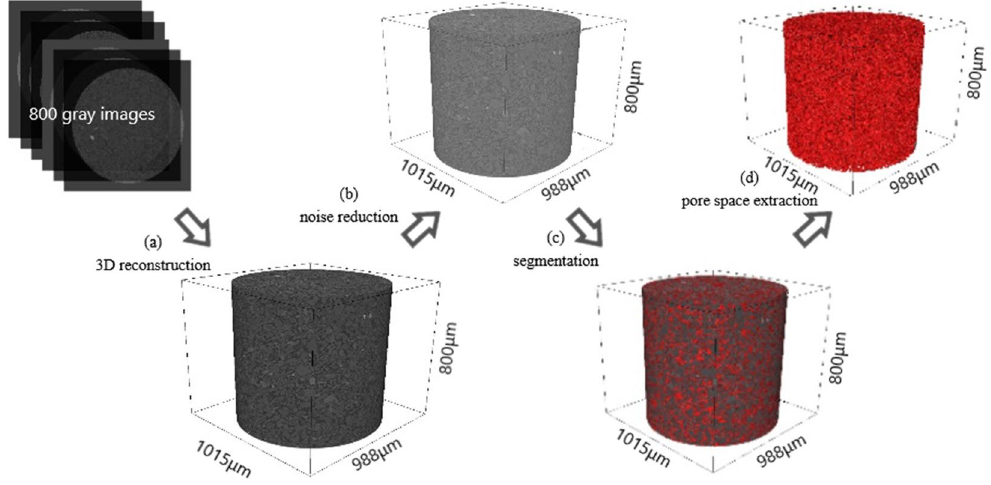
Figure 8. Workflow to reconstruct the 3D pore structure: (a) 3D reconstruction; (b) noise reduction; (c) segmentation; (d) pore space